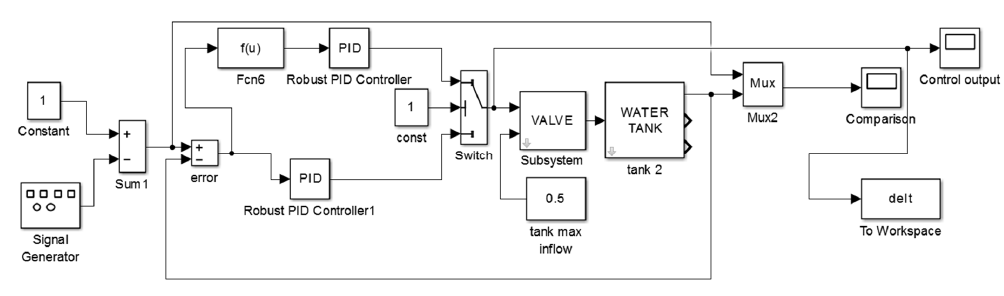
Figure 4. Simulation diagram of linear robust PID (Proportional – Integral – Derivative) controller and nonlinear robust PID controller modified by inverse tangent function.